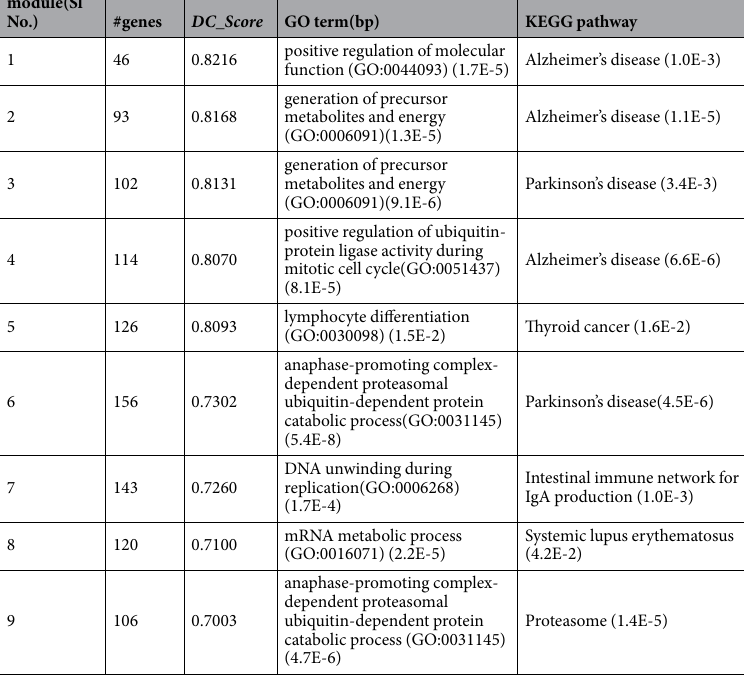
Table 2. GO-terms and KEGG pathway of some identified differentially coexpressed